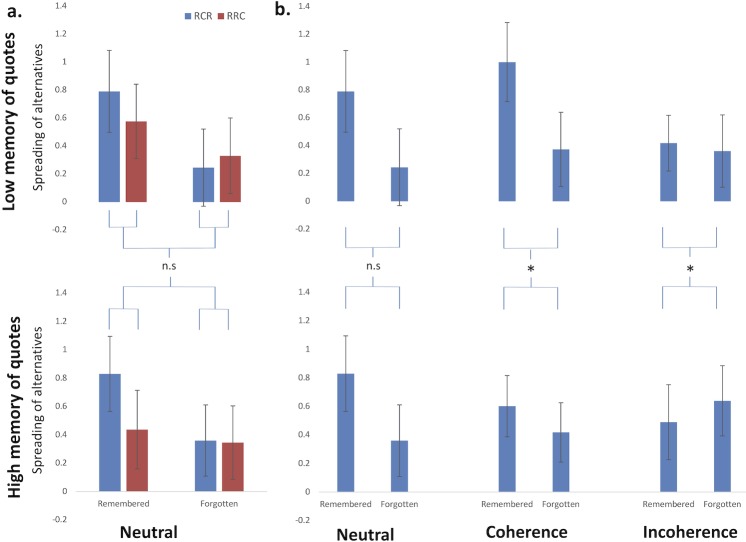
Quote-mediated modulation of CIPC is correlated to memory of quotes.(a) In the neutral quotes condition, the usual episodic dependent CIPC effect was not modulated by memory of quotes. (b) In contrast, comparisons of RCR spreads revealed a modulation of CIPC in relation to quotes memory in the two conditions of interest (* for 0.01≤p<0.05). In the incoherence promoting quotes condition, the spread was significantly lower for subjects who remembered well the quotes than for those that did not. In the coherence promoting quotes condition, the spread was significantly larger for subjects who did not remember well the quotes, suggesting a coherence exerted more on Rating 1 responses than on Choice stage decisions.